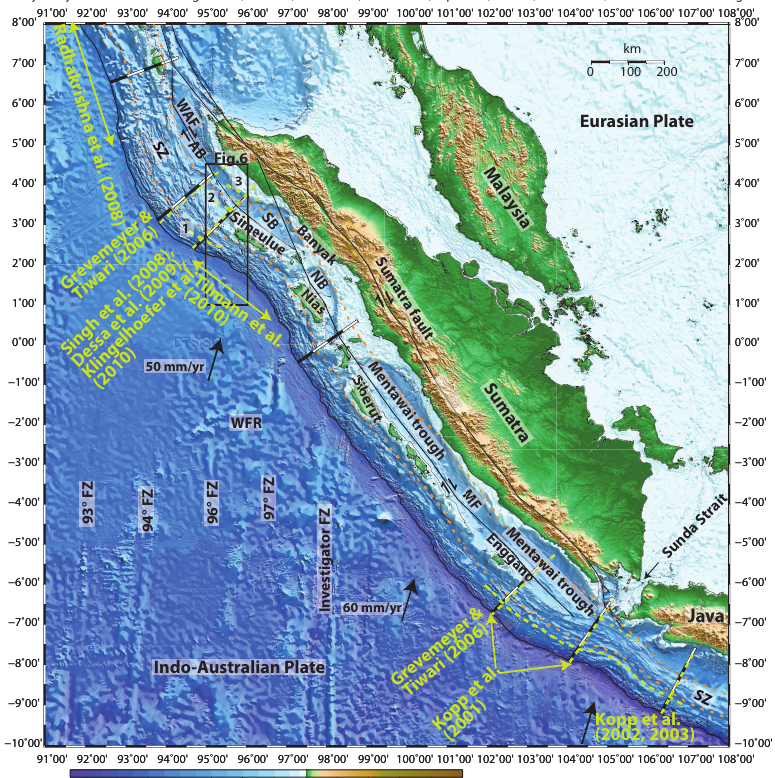
Fig. 2. Bathymetry off Sumatra (multibeam bathymetry, where available underlain by satellite derived bathymetry; Smith and Sandwell, 1997). Tectonic setting is after Newcomb and McCann, 1987. Fracture zones (after Kopp et al., 2008) on the incoming plate as well as subduction direction and velocity (after Simons et al., 2007) are indicated by annotated black arrows on Indo-Australian plate. Major Mentawai islands as well as major faults are annotated along the forearc. Dashed lines sub-parallel to the trench mark the updip and downdip limit of the SZ. The seaward trench-parallel dashed line marking the updip limit of the SZ coincides with the slope break. Profiles and regions are marked and annotated, where additional investigations were available to constrain or refute their limits of the SZ. 200km scales perpendicular to the trench help constrain distance from the deformation front. Deviations of the limits of the SZ from Grevemeyer and Tiwari (2006) by more than 10km are marked by dashed lines and discussed further in the text. AB – Aceh basin; MF – Mentawai fault;